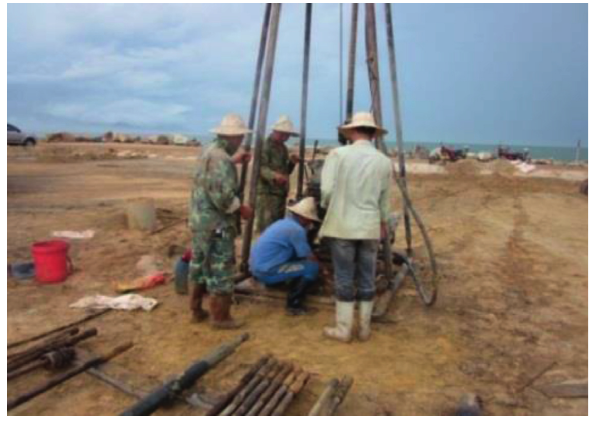
Figure 2: The image of the sampling